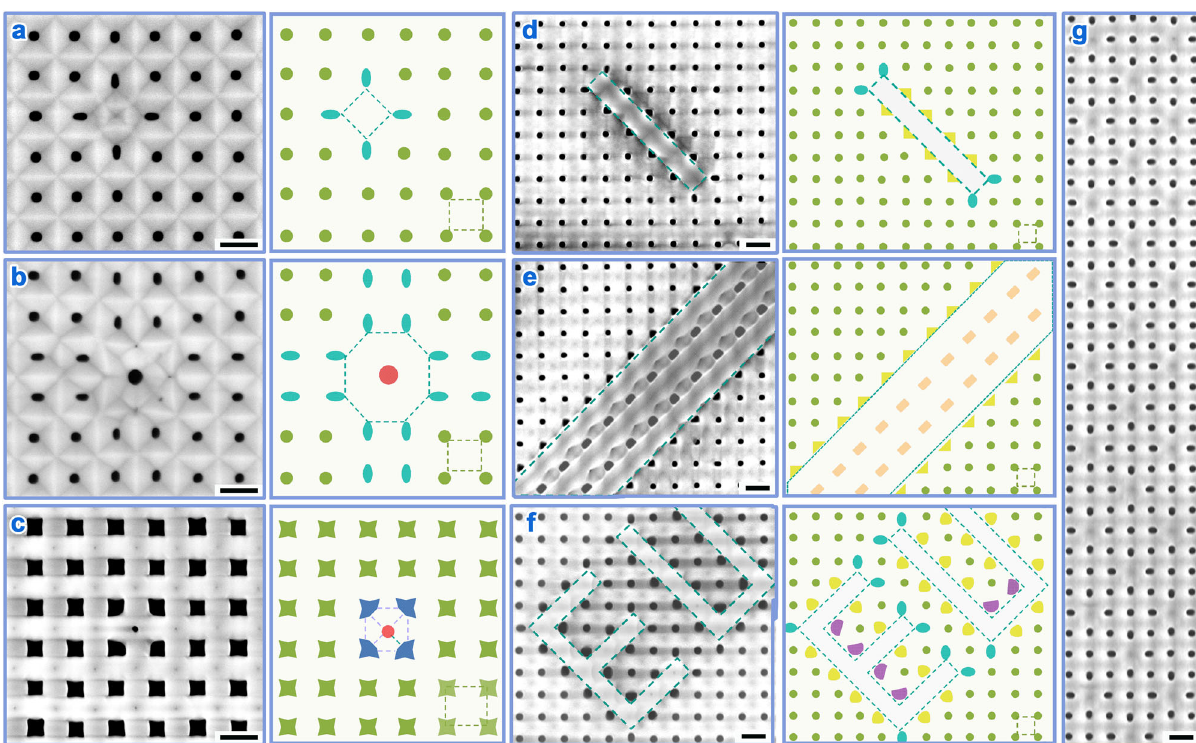
Fig. 4 Templates with mixture spacing-different arrangements. SEM images (left) and schematics (right) of basic tetragonal templates mixed with accessory point units of ( a ) larger-spacing tetragonal arrangement, ( b ) octagonal arrangement, and ( c ) centered tetragonal arrangement, as well as ( d ) line, e area, and ( f ) pattern “ EU ” of larger-spacing tetragonal arrangements. The pores in the basic arrangement are exhibited by green color, and those pores in accessory arrangements are by cyan, red, blue, yellow, orange, and purple colors. g Large-area SEM image of a mixture of two spacing-different tetragonal arrangements. Scale bars: 400